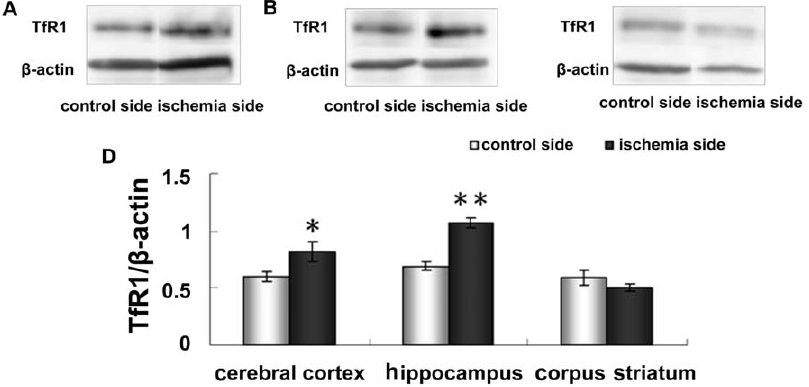
Figure 8. Expression of TfR1 in cerebral cortex (A), hippocampus (B) and corpus striatum (C) of contralateral and ipsilateral side by western blot analysis. Representative TfR blots and corresponding b -actin blots are shown on the top panel. The lower panel (D) shows the summary of TfR expression from three animals in each group. Results are presented as Mean 6 SEM, n=3. **p , 0.01 v.s. contraleteral side, *p , 0.05 v.s. contralateral side.